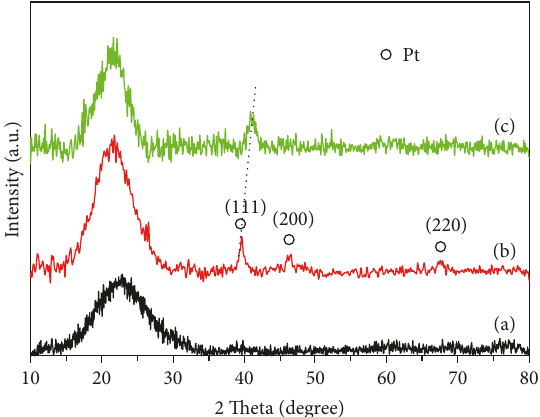
Figure 1: Wide-angle XRD patterns of (a) SiO 2 , (b) Pt/SiO 2 , and (c) Pt-Cu/SiO 2